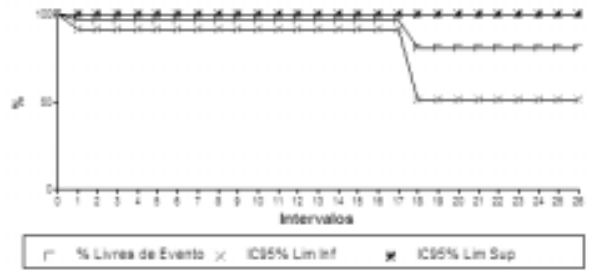
Table 2. Operative data: